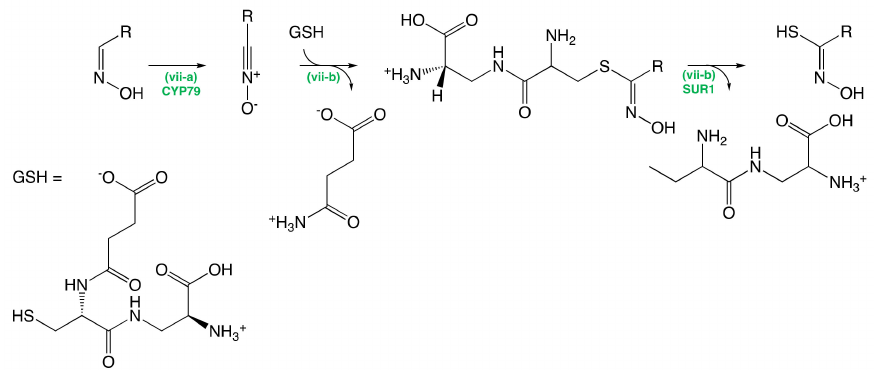
Figure 3. Conversion of Aldoximes to Thiohydroximic Acids. GSH: